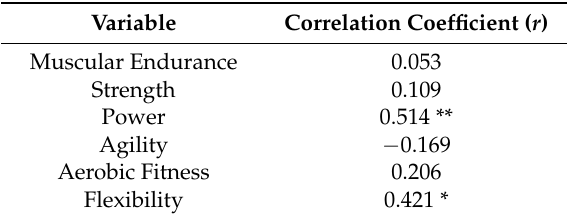
Table 4. Pearson correlations ( r ) between Perception of Physical fitness and Children’s Measured Physical Fitness